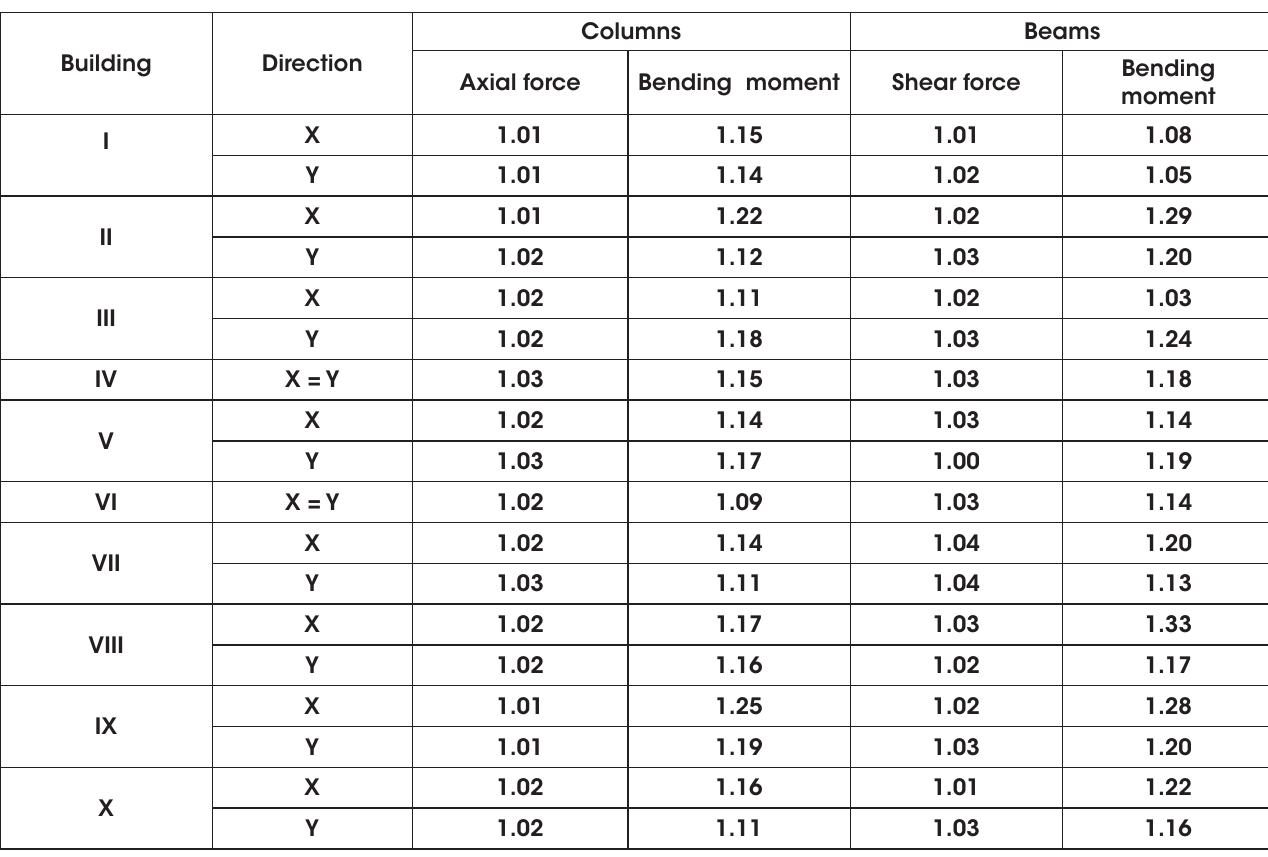
Variation of the height in both directions for structure, the increases experienced by the first order moments, when considering the second order effects, and those increases Average values of ratio (second order effort / first order effort obtained with horizontal actions additional magnified by 0.95